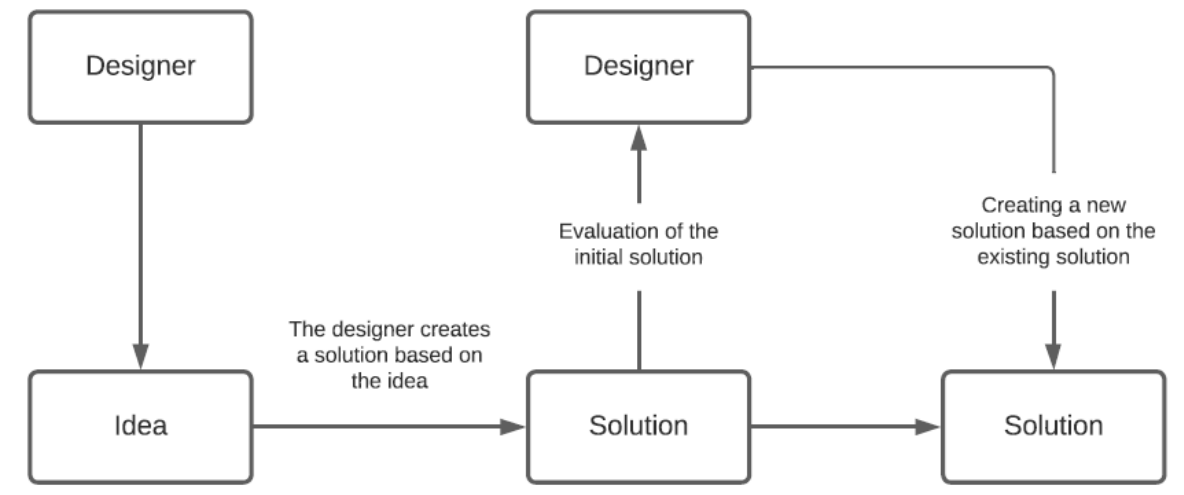
Figure 2. Traditional design process. Source: adapted from [35].